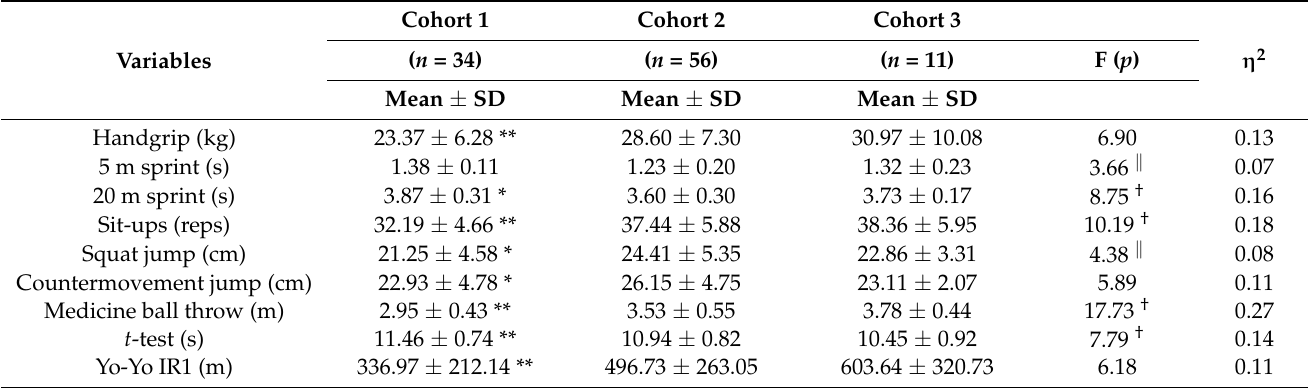
Table 2. Mean ± SD values of age-group-general motor